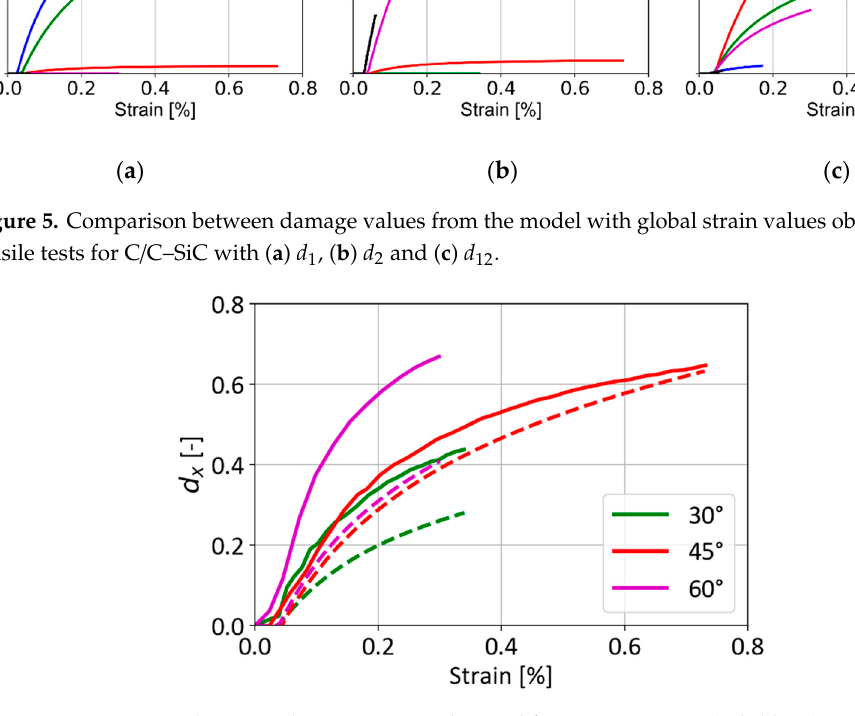
Figure 7. Damage surface with consideration of the interaction of damage parameters in the presence of multiple damage models in the thermodynamics space.